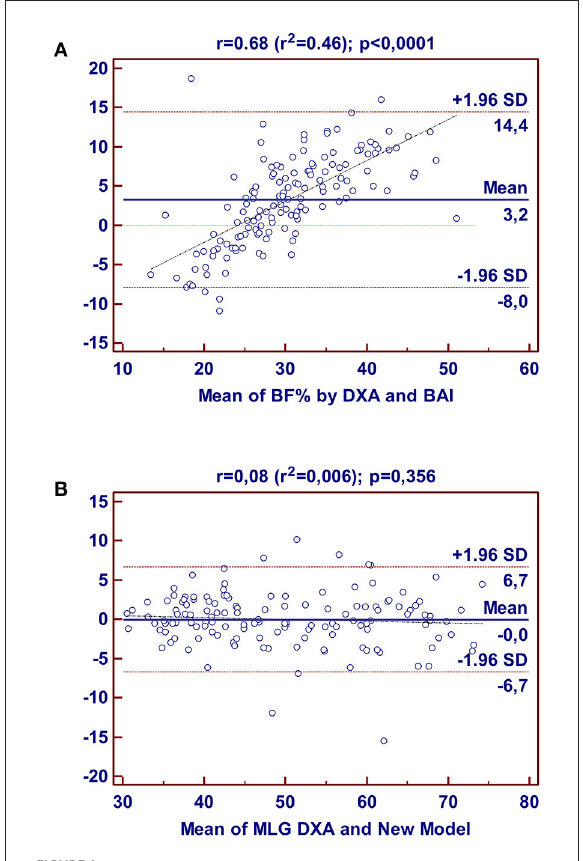
FIGURE1 Bland-Altman plots for the concordance limits between values determined by the reference method (DXA) and BAI for BF% (A) ; and between values determined by the reference method (DXA) and New Model for FFM (B) in Brazilian adults, derived in this